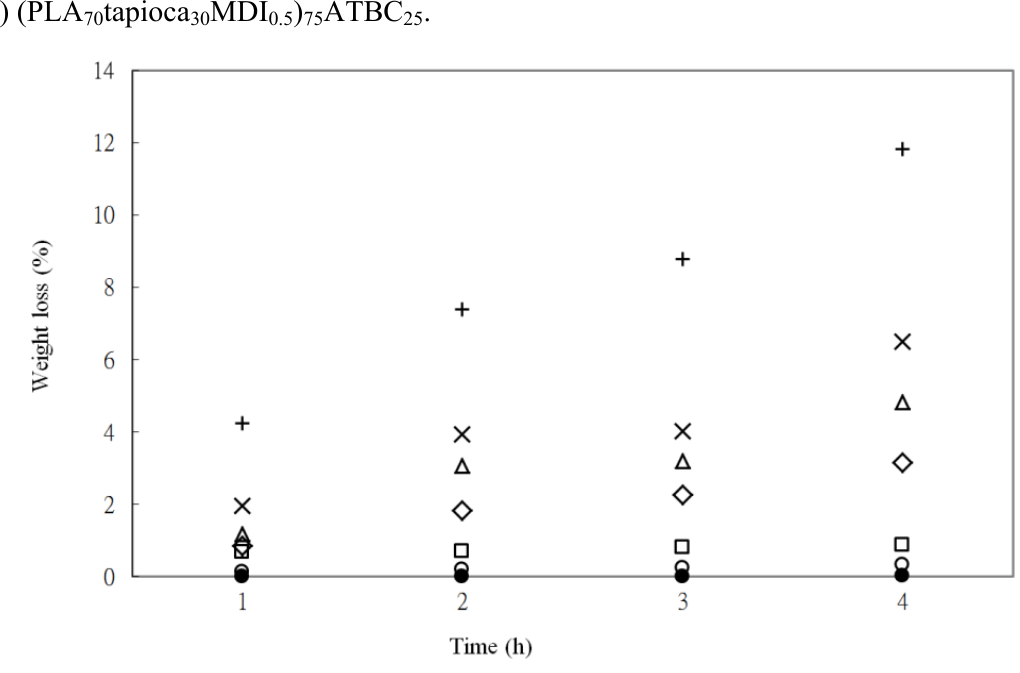
tapioca MDI ; 70 30 0.5 tapioca MDI ) ATBC ; 70 30 0.5 90 10 tapioca MDI ) ATBC ; and 70 30 0.5 80 20